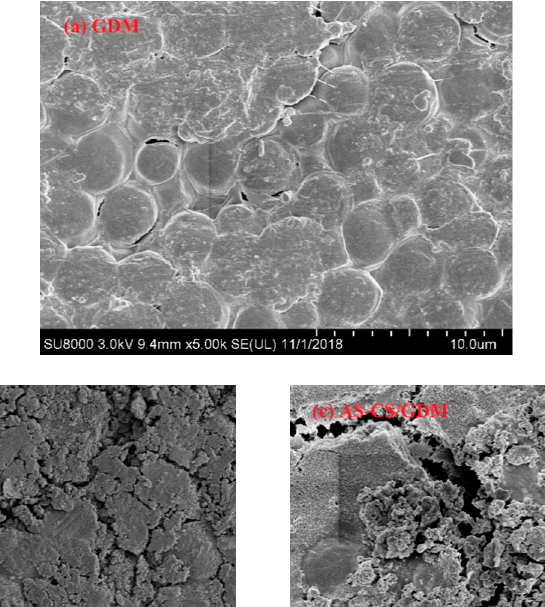
Figure 9. SEM images of the cake layer from the ( a ) GDM, ( b ) AS/GDM and ( c ) AS-CS/GDM systems.